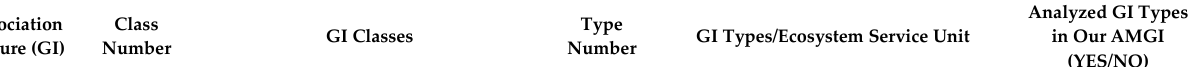
Table A4. A comprehensive GI typology for AMGI, adapted from Green Surge Milestone 23.